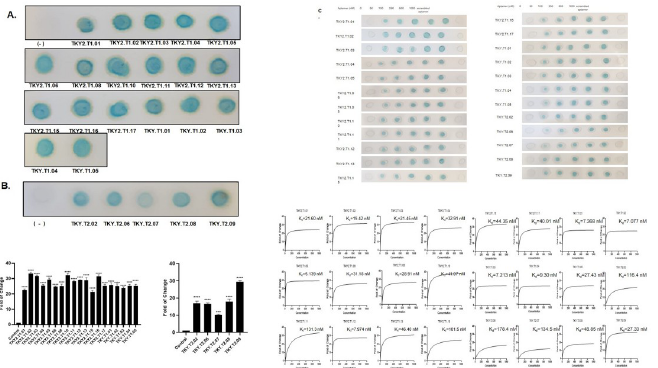
Fig 3. Determination of binding affinity, dissociation constant (K d ) of putative x-aptamers. The binding affinity of putative X-aptamers was determined by dot blot assay against A GHRH NH2 (1–44) target and B GHRH NH2 (1–29) target. C Dose-dependent dot blot assay was performed in increasing doses (0–1000 nM) of X-aptamers. The scramble aptamer was used a negative control for dot-blot analysis. Dot intensities were measured by Image J (imagej.nih.gov/ij/ ) and analyzed by GraphPad Prism 8.0. Nonlinear regression analysis was performed by Sigma Plot v14.0 and K d was calculated. D. The specific binding affinity of selected aptamers against GHRH peptide was determined by both GHRH sandwich ELISA assay (left panel) and dot-blot analysis (right panel) in a dose-dependent manner.